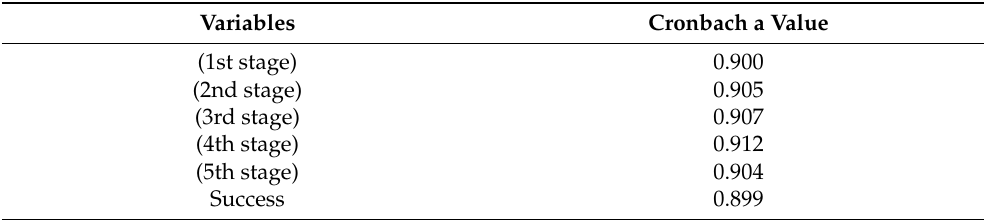
Table 3. Reliability of variables.